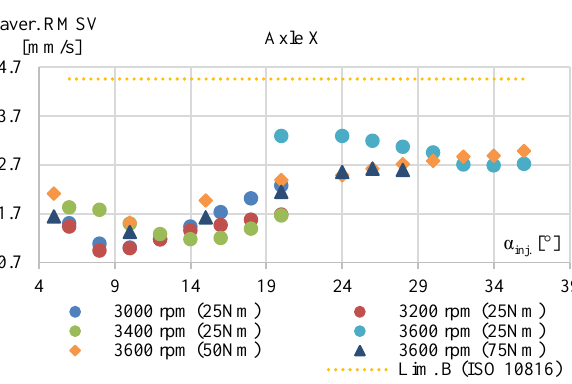
Fig. 14. Average RMS value of the vibration velocity depending on the injection angle for the X axis (25, 50 and 75 Nm)